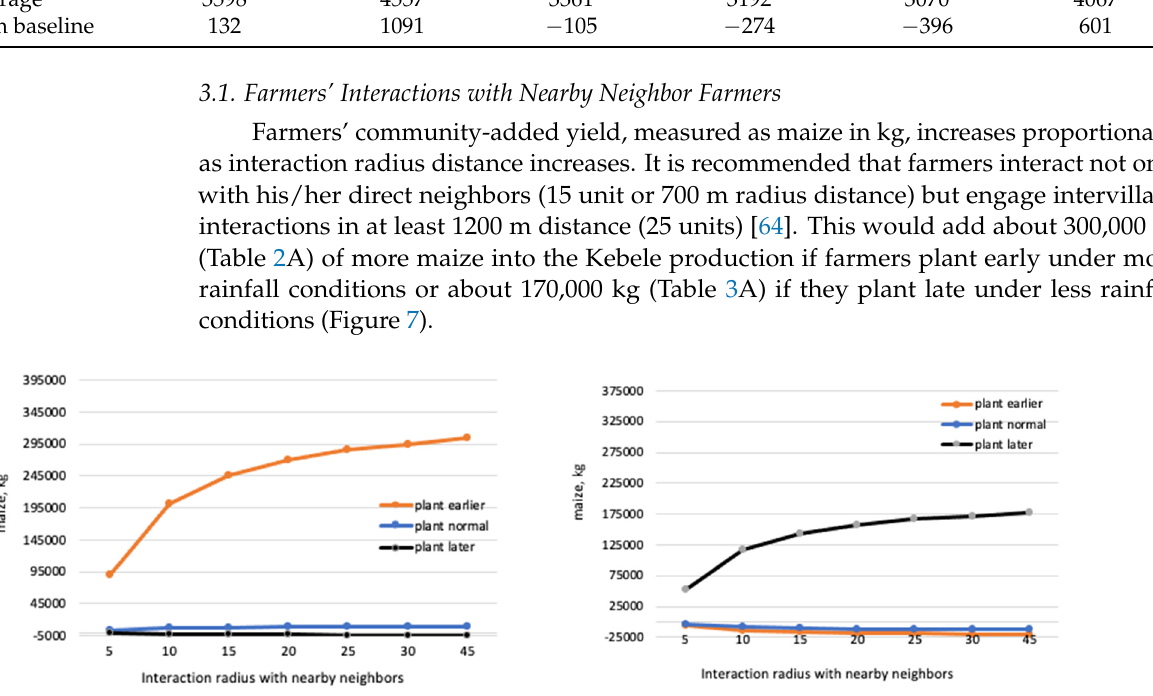
Figure 8. Farmers’ interactions with other farmers in their networks. Each incremental network connection improves farmers’ connectivity and brings about 9000–15,000 more kg of maize into the community, or feeds an additional 180–300 people. In other words, every time a farmer adds another farmer into his/her network, he/she supplies additional food for 180–300 people (Tables A4 and A5). Advantages of diffusion of new information through social networks are studied by many researchers [90]. Social network messages allows farmers to communicate with peers instantaneously with queries and has the potential to allow them to build trust with one another. Singh Nain et al. [91] studied farmers obtaining immediate advice on crop damage, pesticide